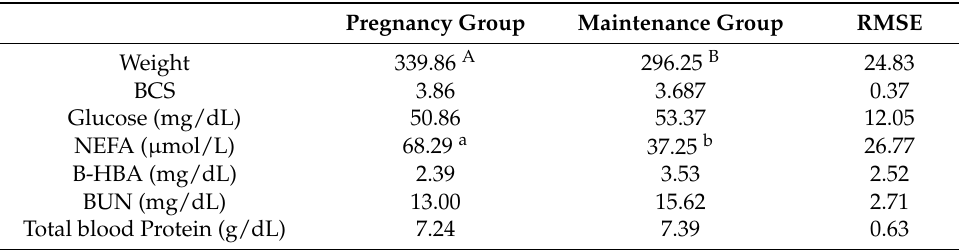
Table 3. Weight, BCS and blood metabolic parameters of jennies in two late pregnancy and mainte- nance fed the same diet (Diet